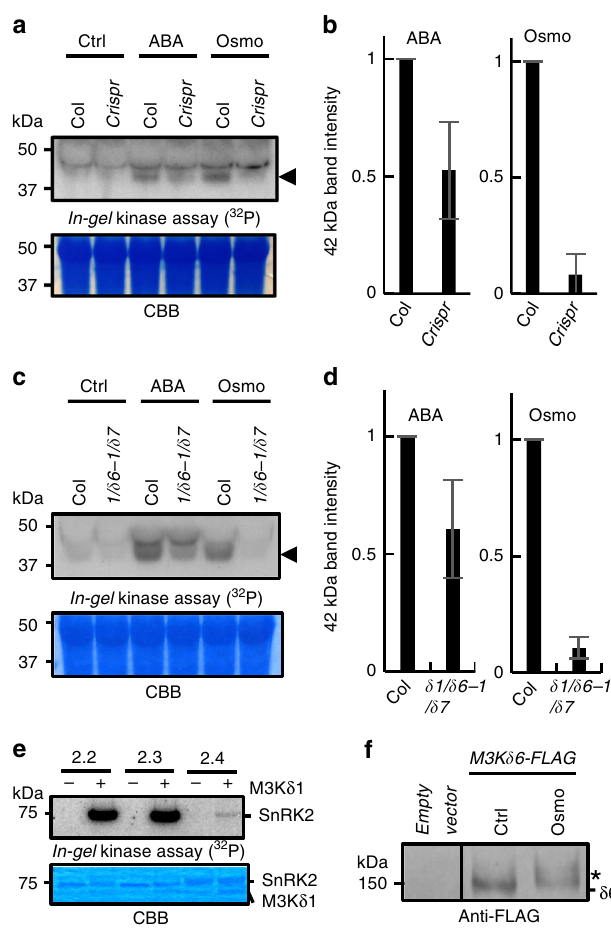
Fig. 6 MAPKK-kinases mediate ABA- and osmotic stress-induced SnRK2 activation in planta . a m3k δ 1crispr m3k δ 6-2 m3k δ 7crispr triple mutant seedlings were incubated in 10 µ M ABA or 0.3 M mannitol (Osmo) for 15 min. SnRK2 activities were tested by in-gel kinase assays. Arrowhead shows SnRK2 activity 23 . b Normalized band intensities as shown in a were measured by using ImageJ. n = 4, means ± s.e.m. c m3k δ 1 m3k δ 6-1 m3k δ 7 T- DNA triple mutant seedlings were incubated in 10 µ M ABA or 0.3 M mannitol (Osmo) for 15 min. SnRK2 activities were analyzed by in-gel kinase assays. d Normalized band intensities as shown in c were measured by using ImageJ. n = 4 experiments, means ± s.e.m. e , Recombinant GST- tagged Arabidopsis SnRK2 protein kinases were incubated with M3K δ 1 kinase domain. SnRK2 kinase activities were analyzed by in-gel kinase assays. f M3K δ 6-FLAG was transiently expressed in Arabidopsis mesophyll cell protoplasts. Protoplasts were incubated in 0.8 M mannitol (Osmo) for 15 min. M3K δ 6 proteins were detected by immuno-blot using anti-FLAG antibody. In the Osmo lane, the M3K δ 6 band showed a slight mobility shift as indicated by an